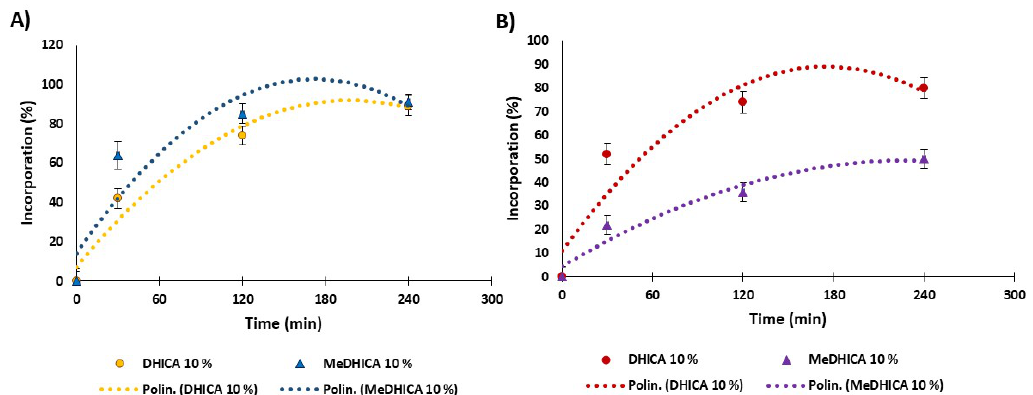
Figure 7. Loading of the indole compounds in the HGel-B (panel A ) or in HGel-C (panel B ) over time. Reported are the mean ± SD values of three experiments and the polynomial regression that fits the data.